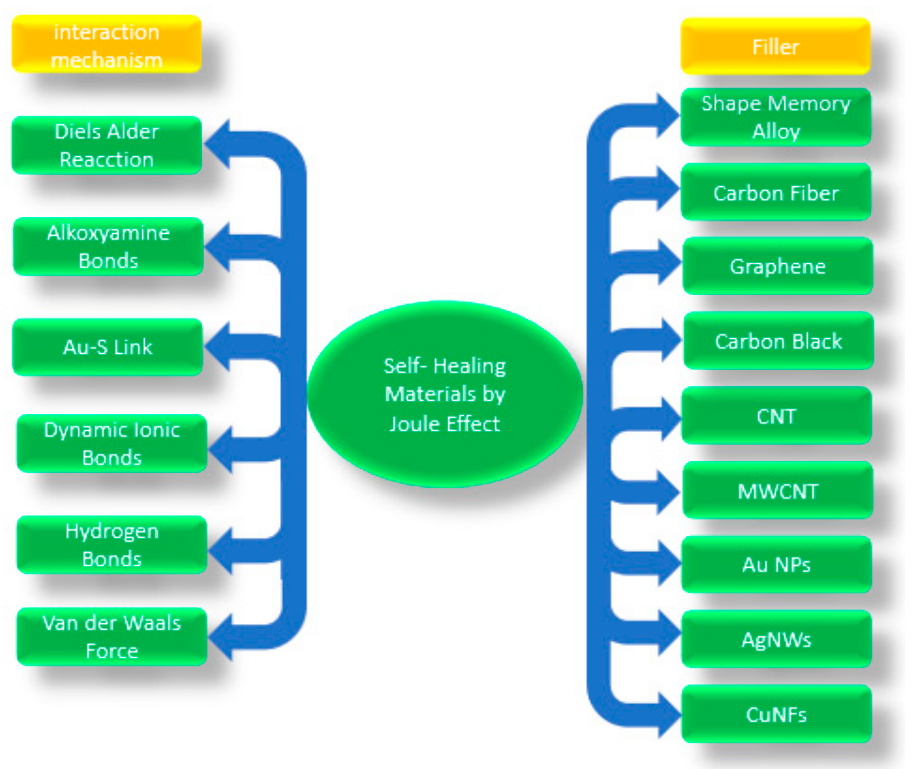
Figure 1. Schematic representation of self-healing material composition [29].